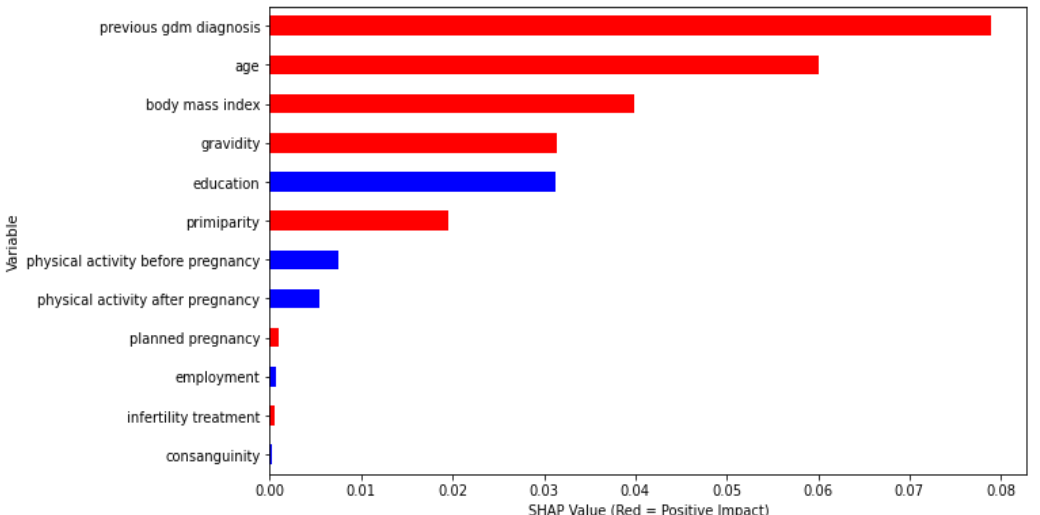
Figure 2. Feature contributions for the GDM model using SHAP values. Red shows that the features that positively contributed to GDM diagnosis while blue represents negatively contributed features.